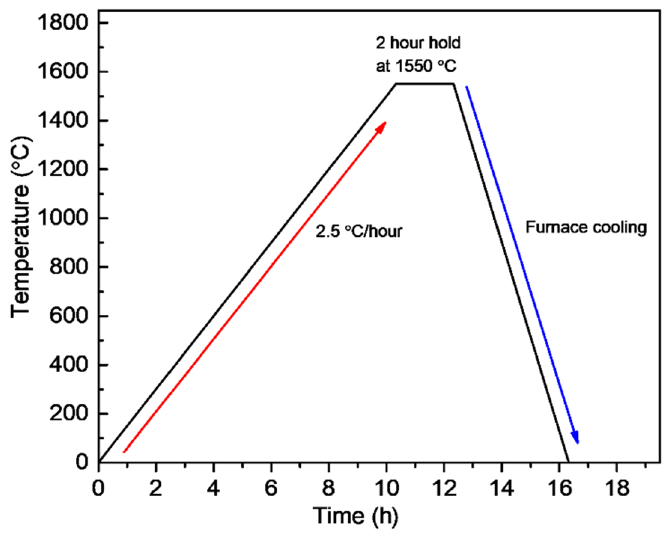
Figure 3. Sintering schedule followed by an atmosphere post debinding process in air.